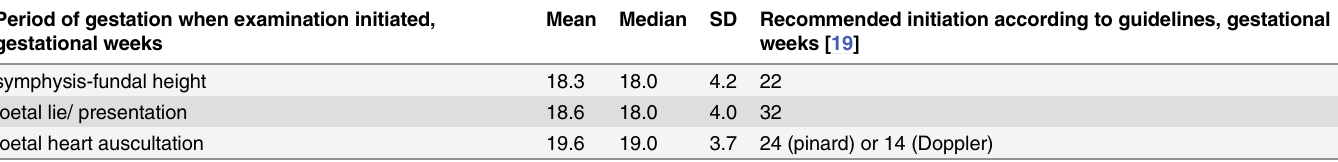
Table 2. Period of gestation when selected examinations were initiated (n =